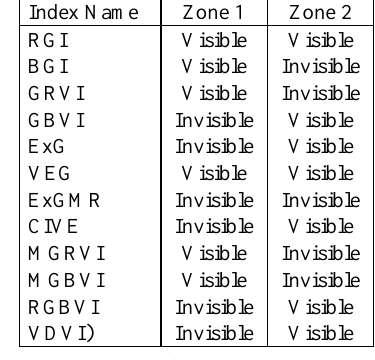
Figure 4. Comparison of different VI grayscale images (from top to bottom: RGB, RGI, BGI, GRVI, GBVI, ExG, VEG, ExGMR, CIVE, MGRVI, MGBVI, RGBVI and VDVI).